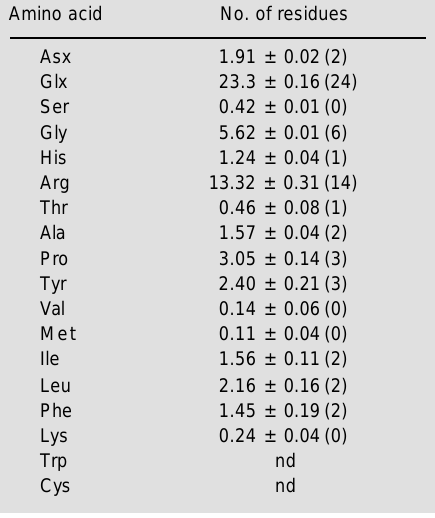
Table 1 - Amino acid composition of the 6.5-kDa protein isolated from the seeds of the prickly- pear, as determined by Pico Tag technology. Composition is reported as number of residues per mol of protein based on a molecular mass of 6500. The values for cystein and tryptophan were not determined (nd). Number within parentheses represent the assigned integral